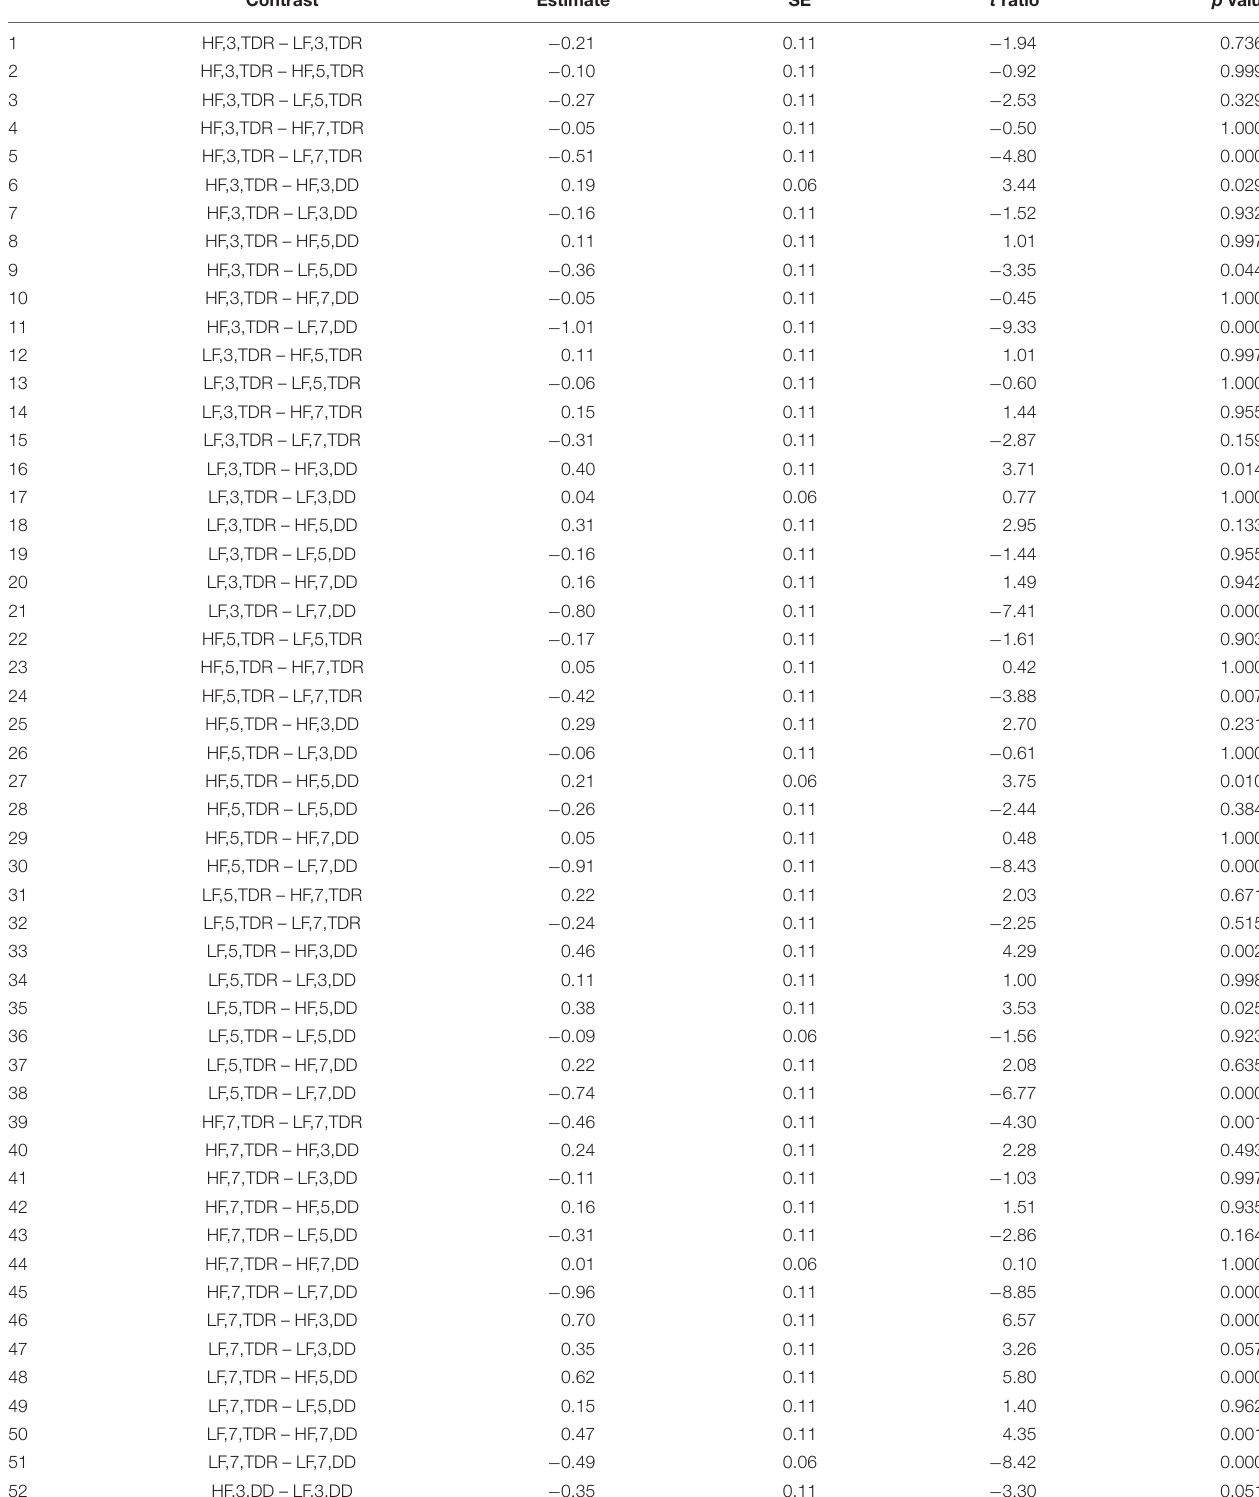
TABLE 3 | Word reading post hoc comparisons on the z -scores using Tukey